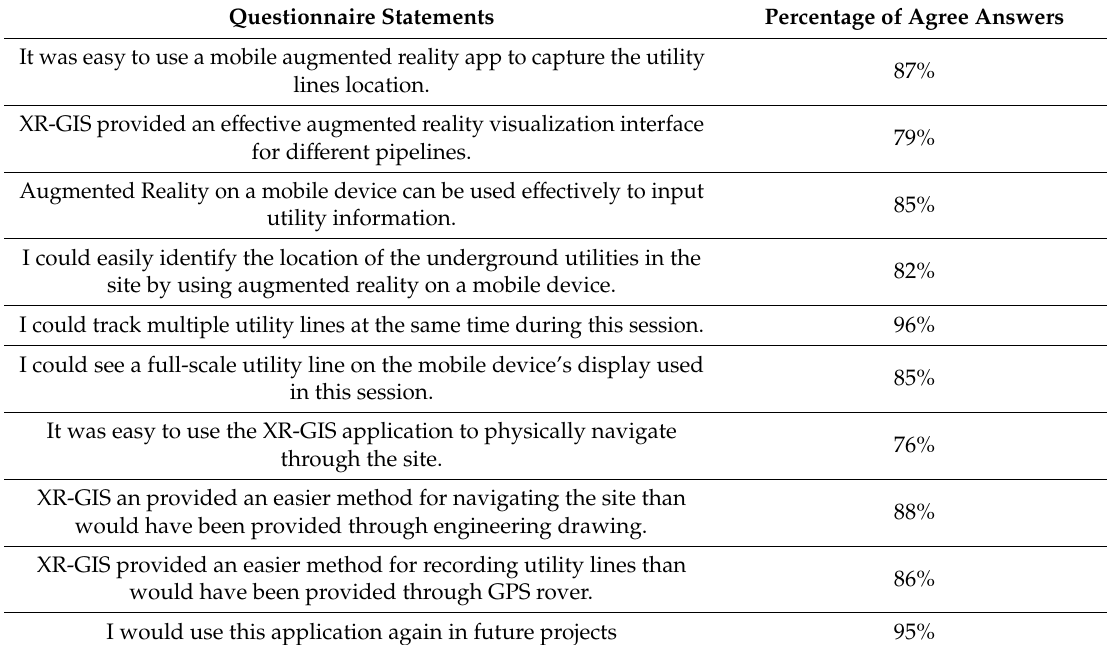
Table 4. Percentage of participants that agreed with each